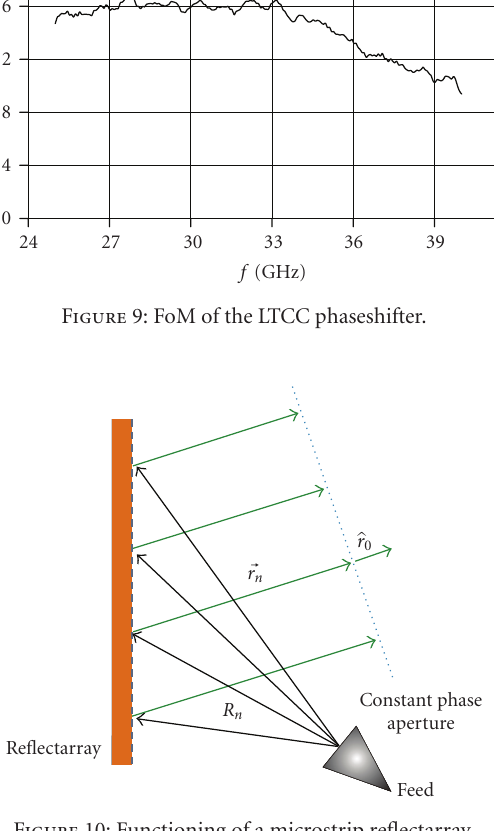
Figure 10: Functioning of a microstrip reflectarray.